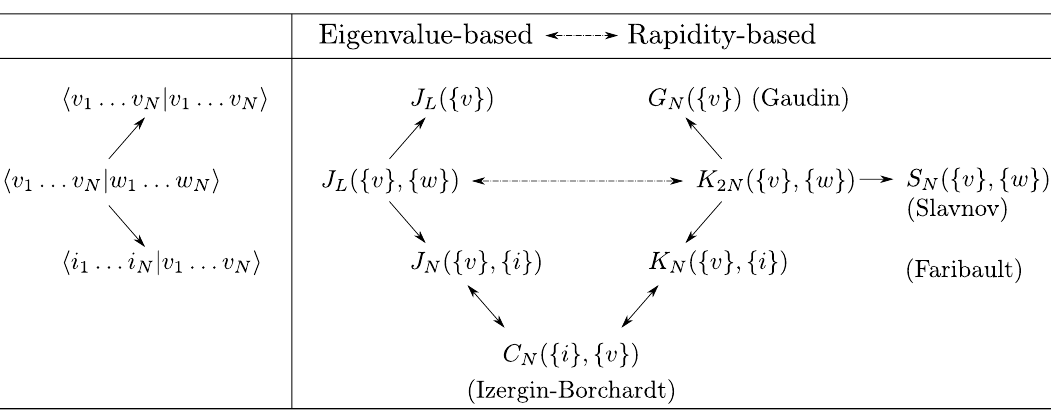
Figure 1: Overview of all relevant matrices and their interconnections for inner products in Richadson-Gaudin